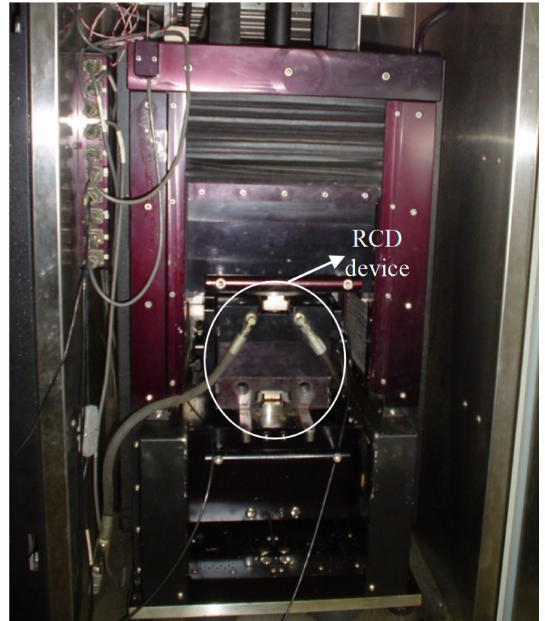
Figure 6. RCD device mounted into the test